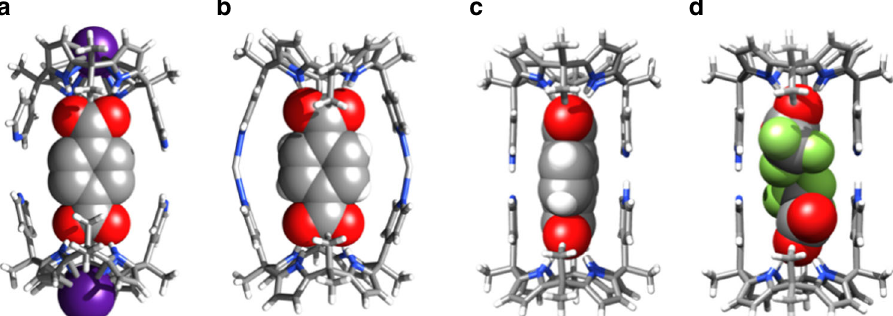
Fig. 5 Crystal structures of the molecular capsules. a 1 2 ⊃ 2 (cid:129) Cs + , which lacks a bridging cation (H + or Ag + ) between the pyridine arms. b 1 2 ⊃ 2 , wherein the pyridine moieties are bridged by Ag + cations. c 1 2 ⊃ 2 and d 1 2 ⊃ TFA 2 , wherein the pyridine arms are connected via a bridging proton as inferred from the metric parameters and charge considerations